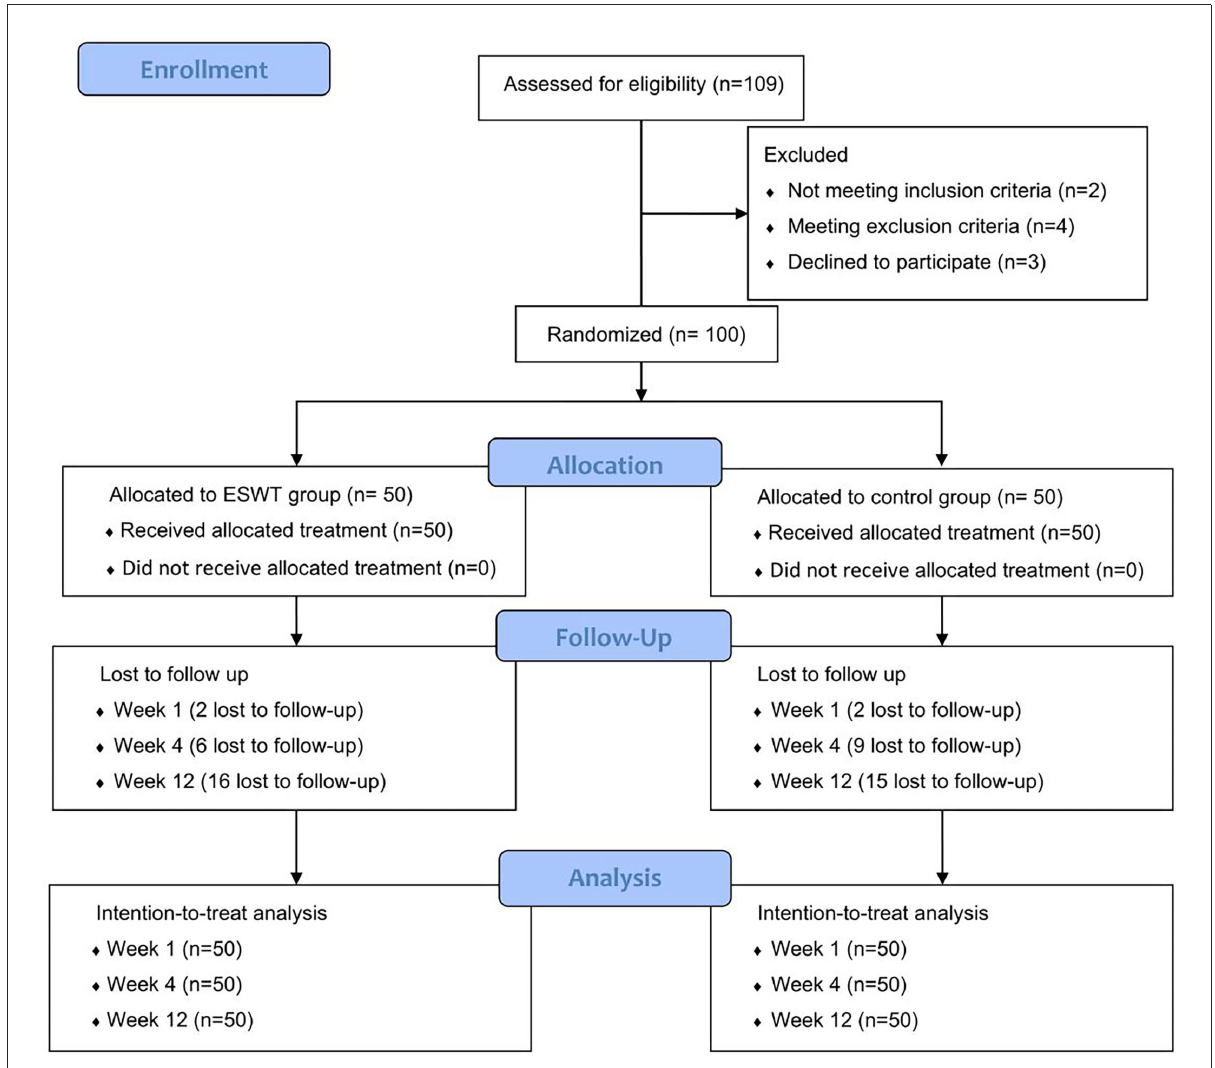
FIGURE2 Consort flow diagram. A total of 100 participates were randomized into the control group and the ESWT group, who were followed up at weeks 1, 4, and 12. All participates were included in the intention-to treat